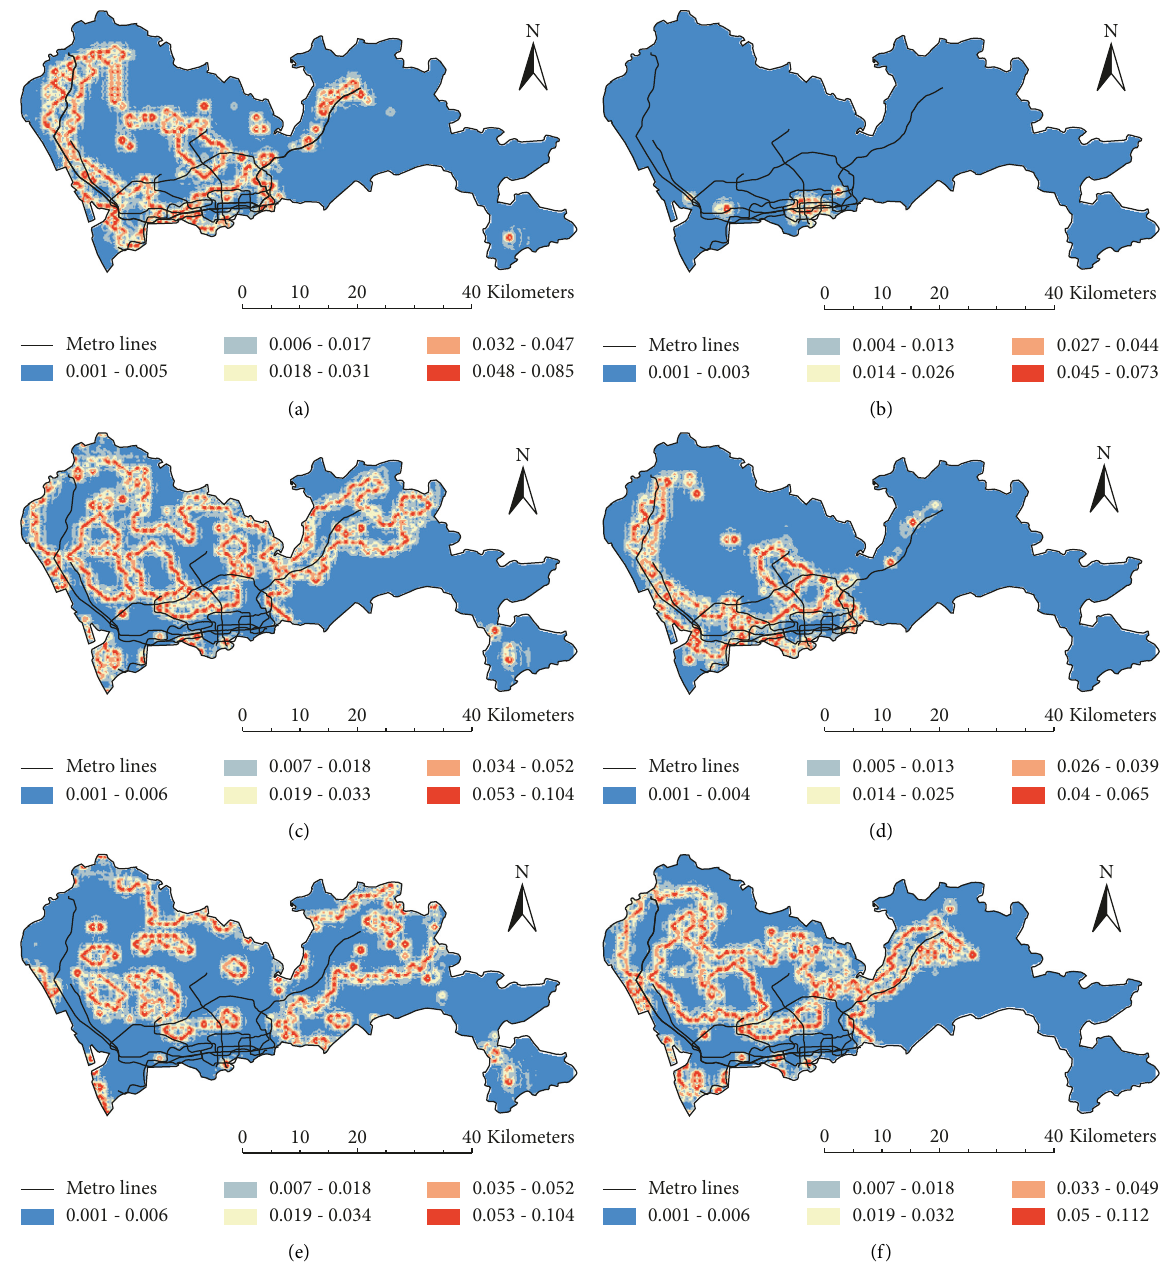
Figure 6: Slope of the reliability of Table 1: Median distance between the boundary and urban railway lines.